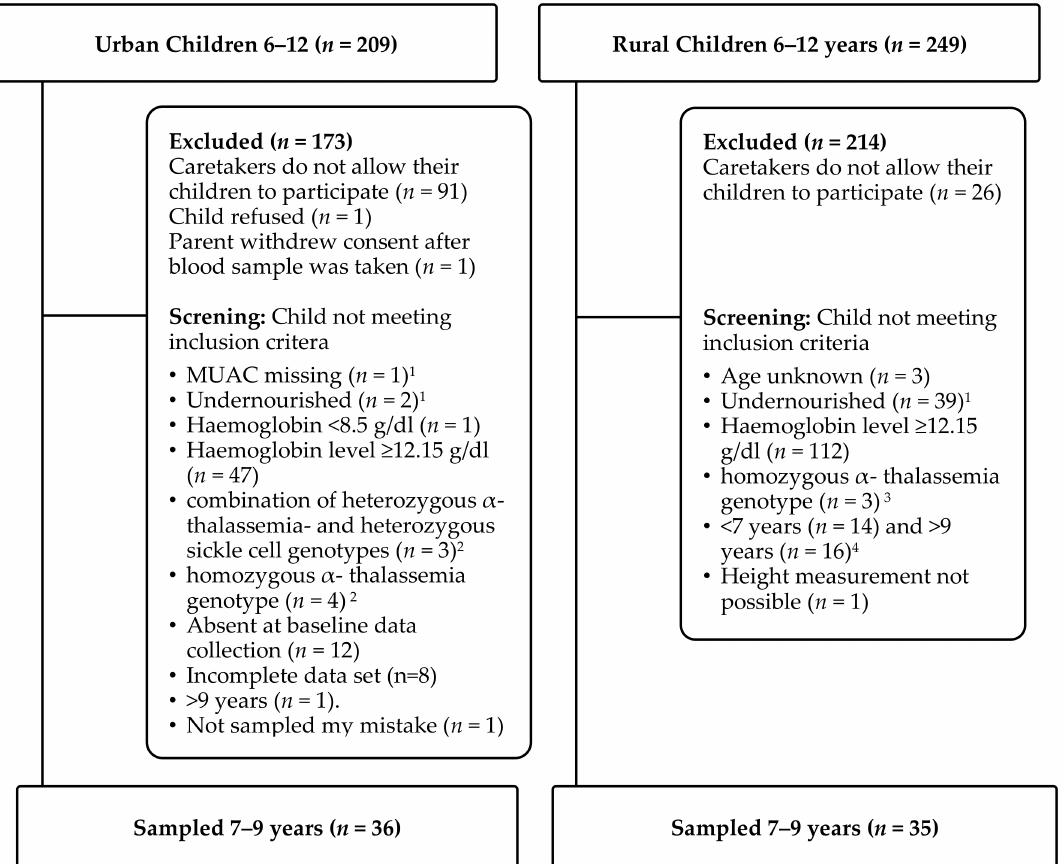
Figure 1. Consort Diagram of the Sampling Procedure. 1 Moderate undernutrition defined as mid-upper arm circumference (MUAC) < 14.5 cm for children aged 5–9 years and < 18.5 cm for children aged 10–15 years by National AIDS / STI Control Program [21]; 2 Blood samples for genotyping collected at screening; 3 Blood samples for genotyping collected at baseline; 4 Reference dates: 3 May 2017 and 7 May